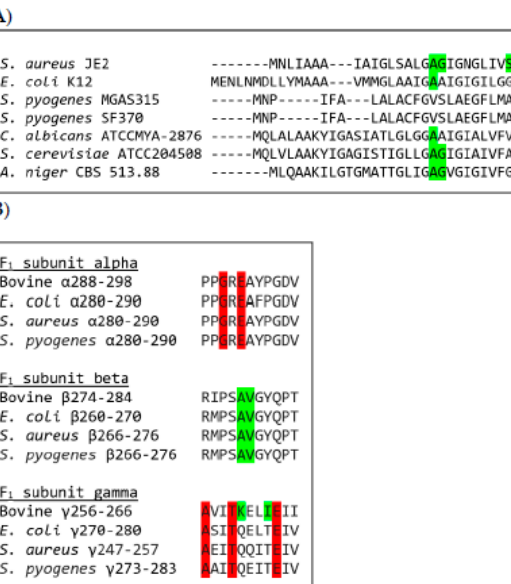
Figure 1. Amino acid sequence alignments of four ATP synthase subunits involved in the binding of tested ATP synthase inhibitors. ( A ) Amino acid sequence alignments of the F 0 subunit c for bacterial and fungal isolates. The essential carboxyl-containing amino acid (glutamic acid (E) or aspartic acid (D)) for proton translocation is indicated with the asterisk and bold letters. Amino acids that upon mutation in S. aureus conferred resistance to tomatidine are marked in green [11], along with shared amino acids in the other microorganisms. The amino acid residues constituting the binding site of oligomycin A in S. cerevisiae are marked in red [25], along with shared amino acids in the other microorganisms. ( B ) Amino acid sequence alignments of short regions of the ATP synthase subunits α , β and γ involved in the binding of resveratrol to the F 1 -domain of the bovine ATP synthase [34], with corresponding regions of E. coli as previously aligned [18]. Here, alignments of corresponding sequences for S. aureus and S. pyogenes are added. Residues marked in green are involved in hydrophobic interactions with resveratrol/piceatannol, while residues marked in red provide additional nonpolar interactions [34]. The residues involved in resveratrol binding are identical between the E. coli , S. aureus and S. pyogenes